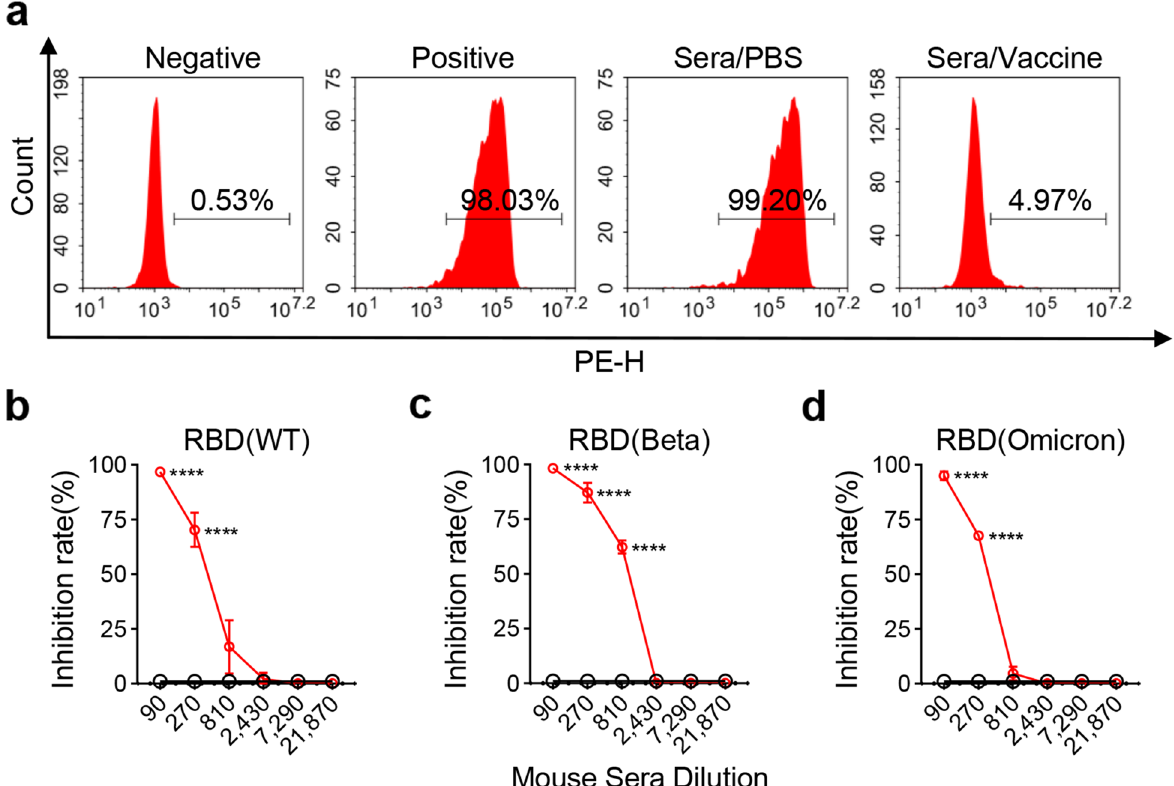
Fig. 3 Inhibition of the binding of the RBD to hACE2 receptor. a SARS-CoV-2 RBD (Omicron)-Fc fusion protein was added to 293 T/hACE2 cells in the presence or absence of sera at a dilution of 1:90, followed by incubation with anti-human IgG-PE labeled antibodies. The representative graphs followed the treatment from the left to right orderly: cells were stained with anti-human IgG-FITC conjugated antibody alone in the absence of RBD-Fc fusion protein (negative control); the cells were incubated with RBD-Fc fusion protein pre-incubated in the absence of sera (positive control); the cells treated with the sera from PBS group (sera/PBS); the cells treated with the sera from the vaccine group (sera/vaccine). b‑d Inhibition rate of RBD-WT ( b ), RBD (Beta) ( c ), RBD (Omicron) ( d ) binding to cell surface ACE2 receptor in the presence of sera obtained day 56. Data are mean SEM. p value < 0.05 were considered statistically significant (* p < 0.05; ** p < 0.01; *** p < 0.001; **** p < ±